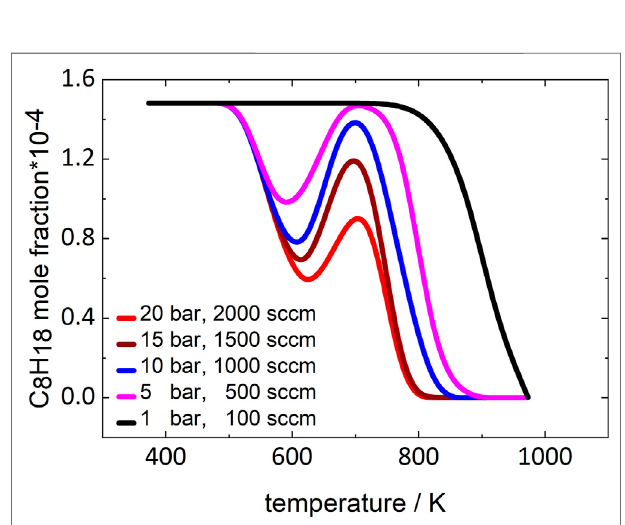
FIGURE 4 | Simulated mole fractions of iso-octane with constant residence time at 1, 5, 10, 15, and 20 bar. Simulations performed using the model of Atef et al.